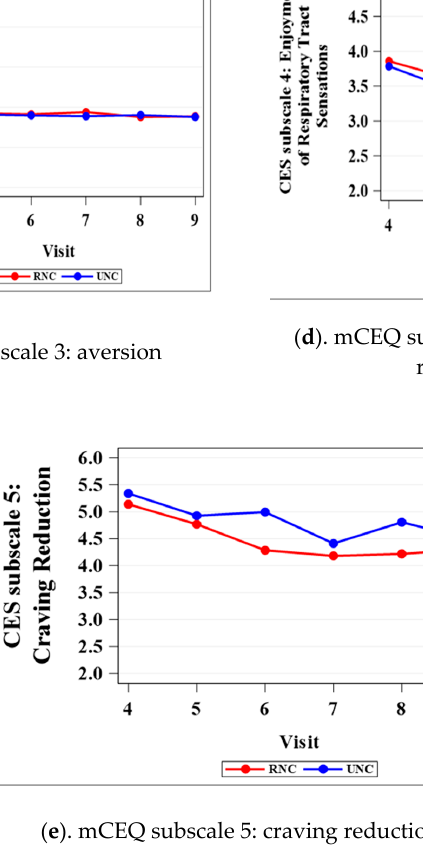
Figure 1. Mean scores of RNC (reduced nicotine content) and UNC (usual nicotine content) on each of the five mCEQ (modified cigarette evaluation questionnaire) subscales from visits 4 to 9. Table 1. Results of analyses comparing mCEQ subscales in RNC vs. UNC groups.